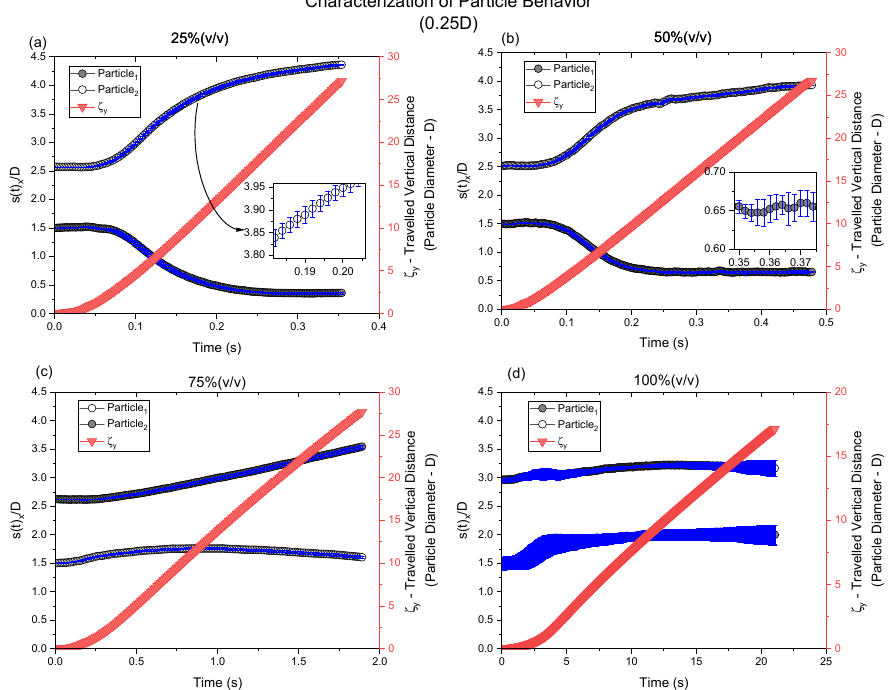
Figure 5. Plots representing normalized particle vertical and lateral positions as function of time in four different ( v/v ) mixtures of glycerin and water: ( a ) 25%, highest repulsion behavior demonstrated in a wide bottle-shaped trajectory; ( b ) 50%, less prominent repulsion demonstrated by a flattened bottle-shaped trajectory; ( c ) 75%, linear repulsion; and ( d ) 25%, no interaction.